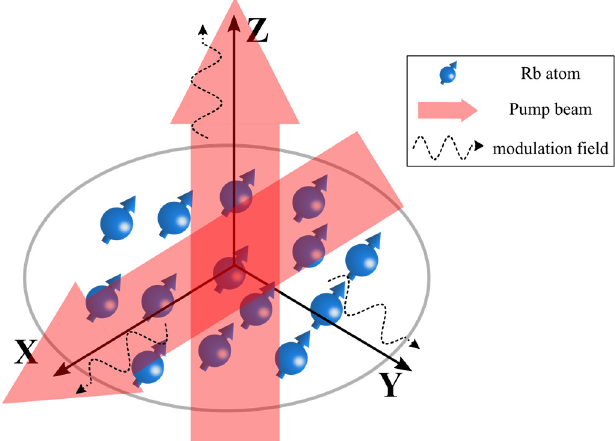
Figure 1. Diagram of three-axis magnetic field measurement. Two pump beams along x - and z -axes are used to polarize the alkali-metal atom.